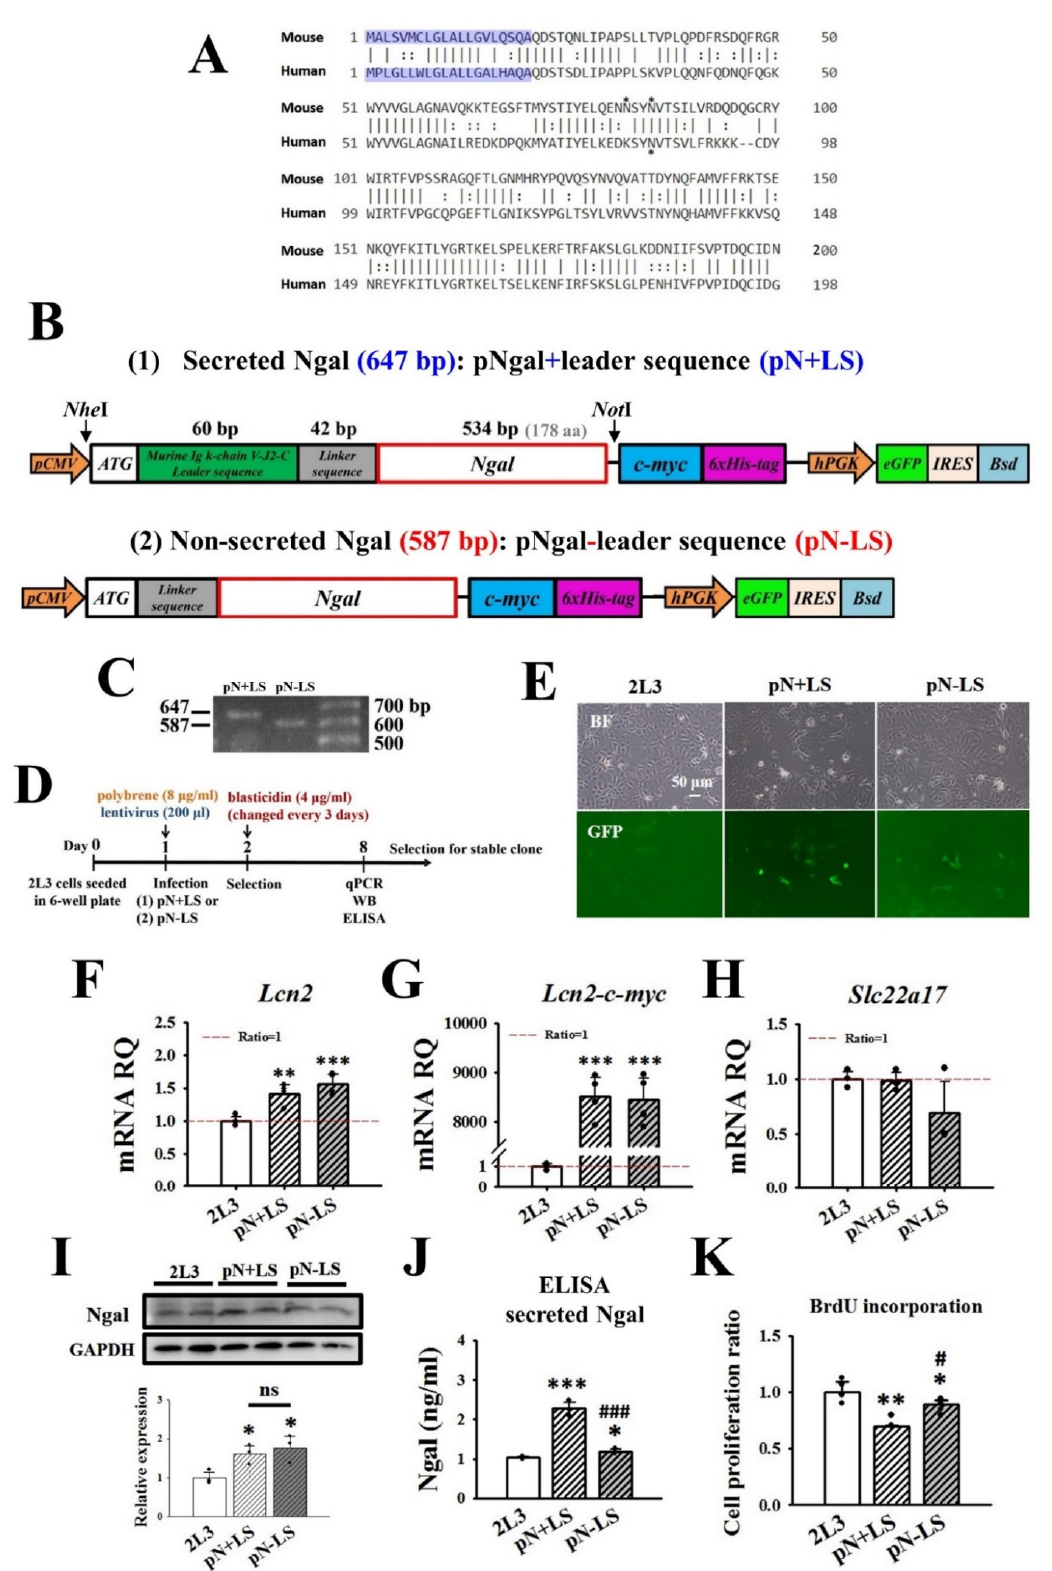
Figure 7. Effects of transfection with pN + LS and pN − LS on NGAL expression and cell proliferation in 2L3 cells. ( A ) Alignment of mouse NGAL (NP_032517.1) and human NGAL (NP_005555.2) proteins. The 20-aa signal peptides are shown in blue. The two reported N-linked glycosylation sites on Asn